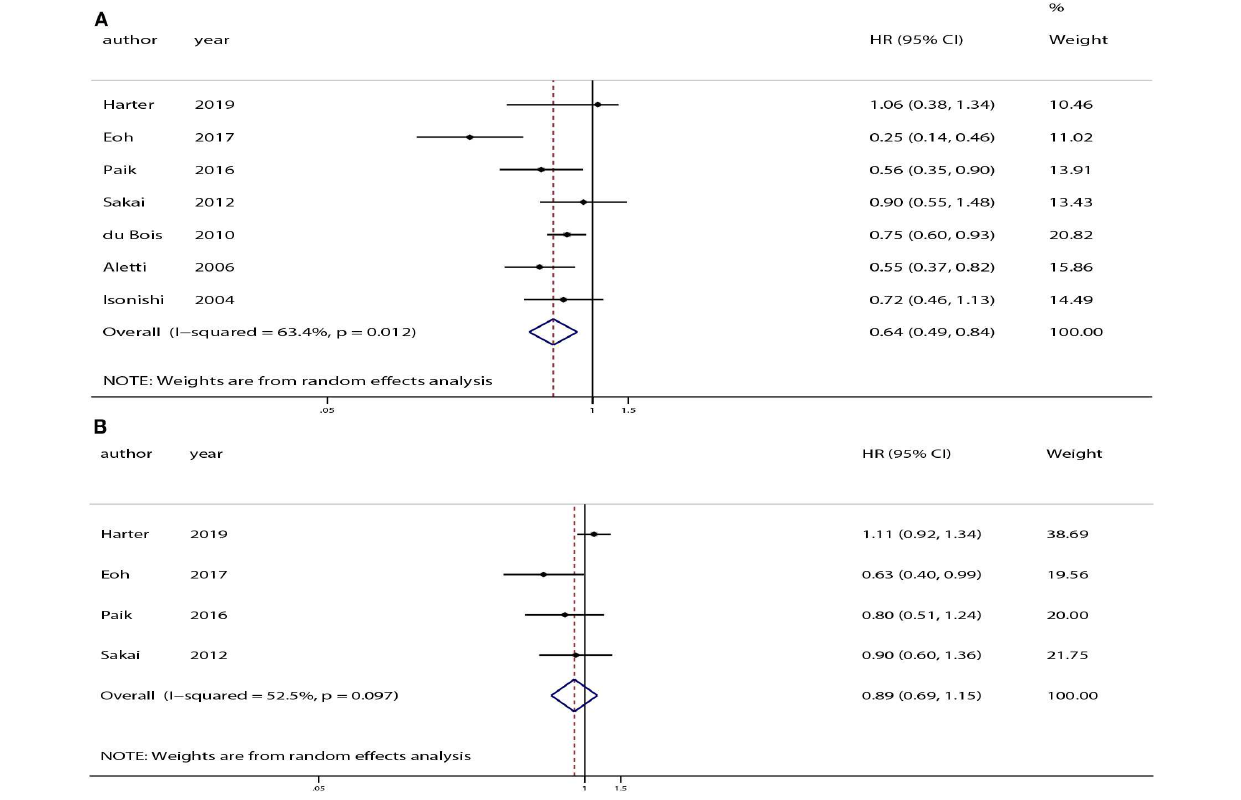
Frontiers in Oncology |